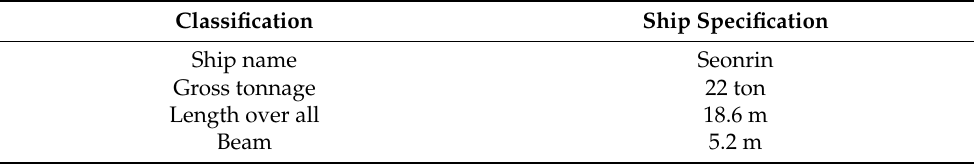
Table 2. A specification of the test ship.